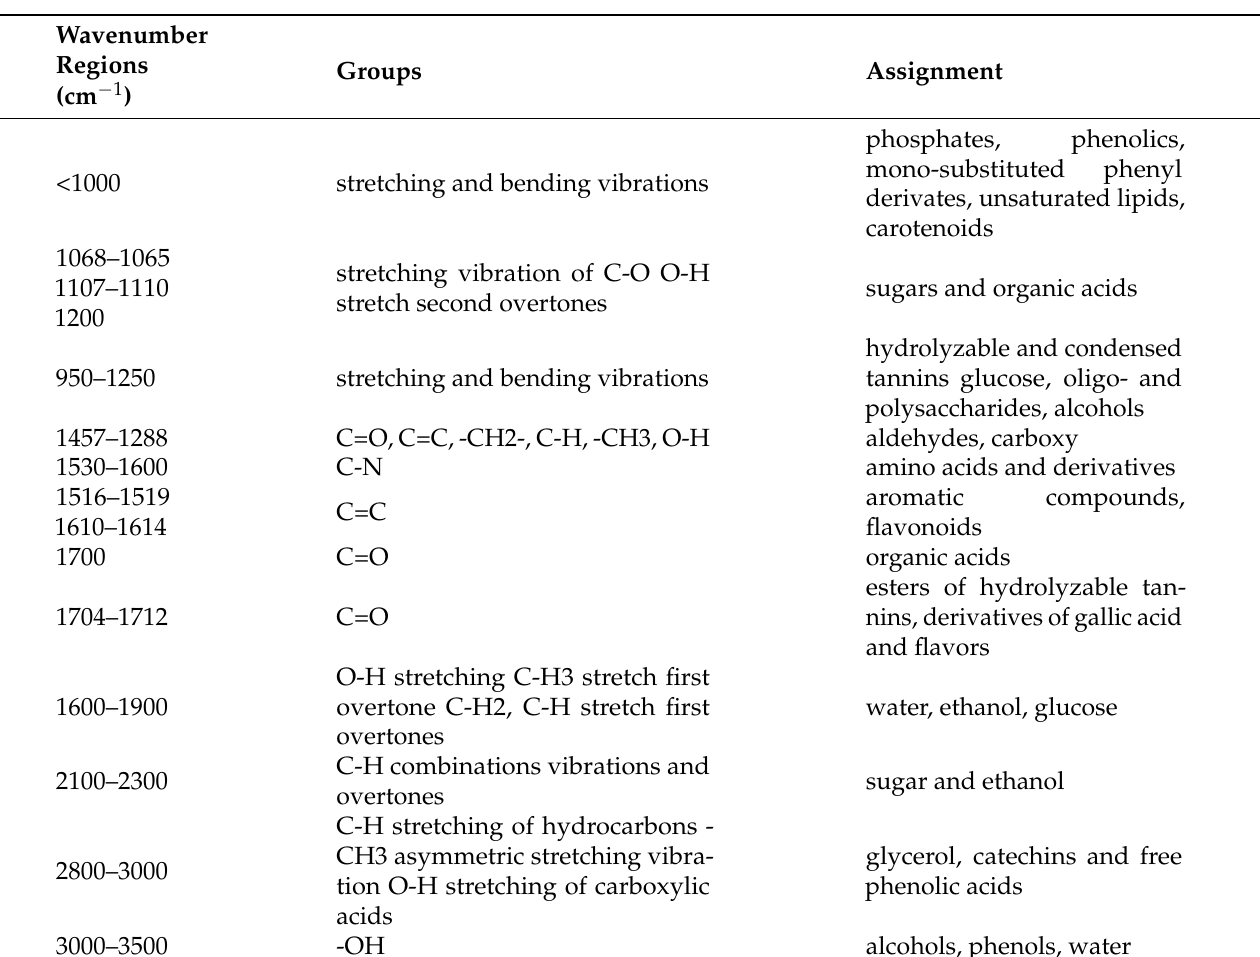
Table 1. Characteristic wavenumbers (cm − 1 ) for bending vibrations and stretching in wine samples, as